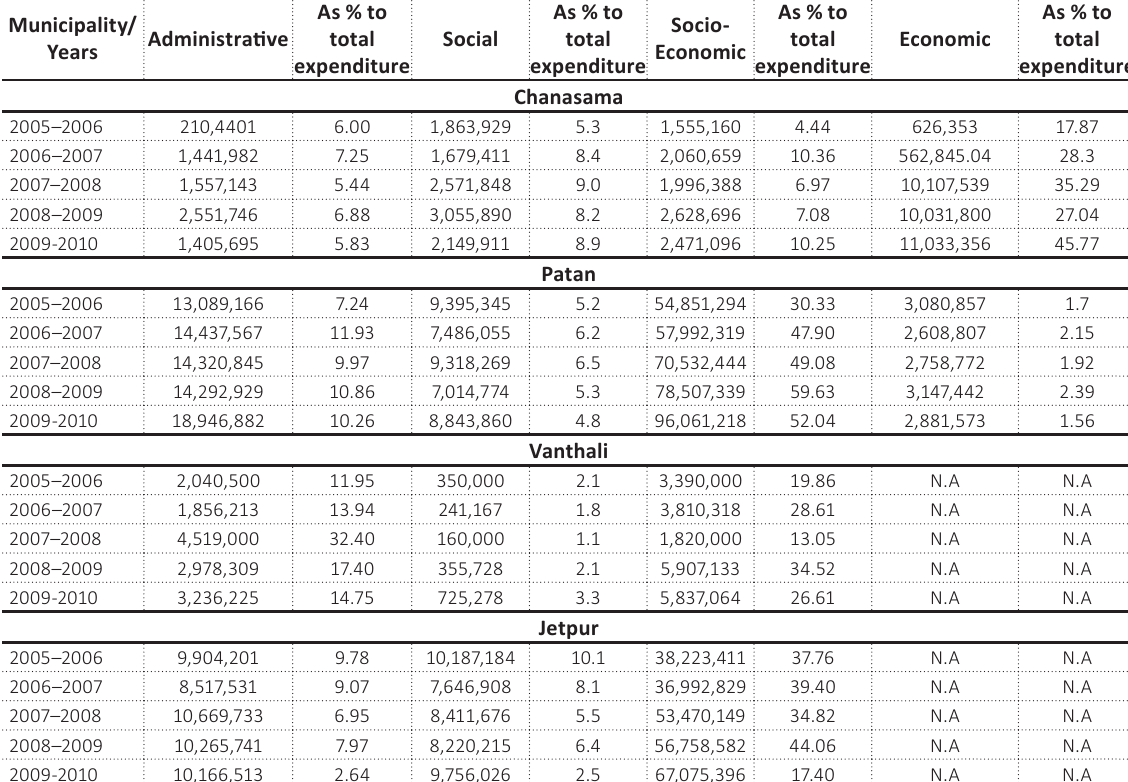
Source: Budgets of various municipalities, 2005–2006 to